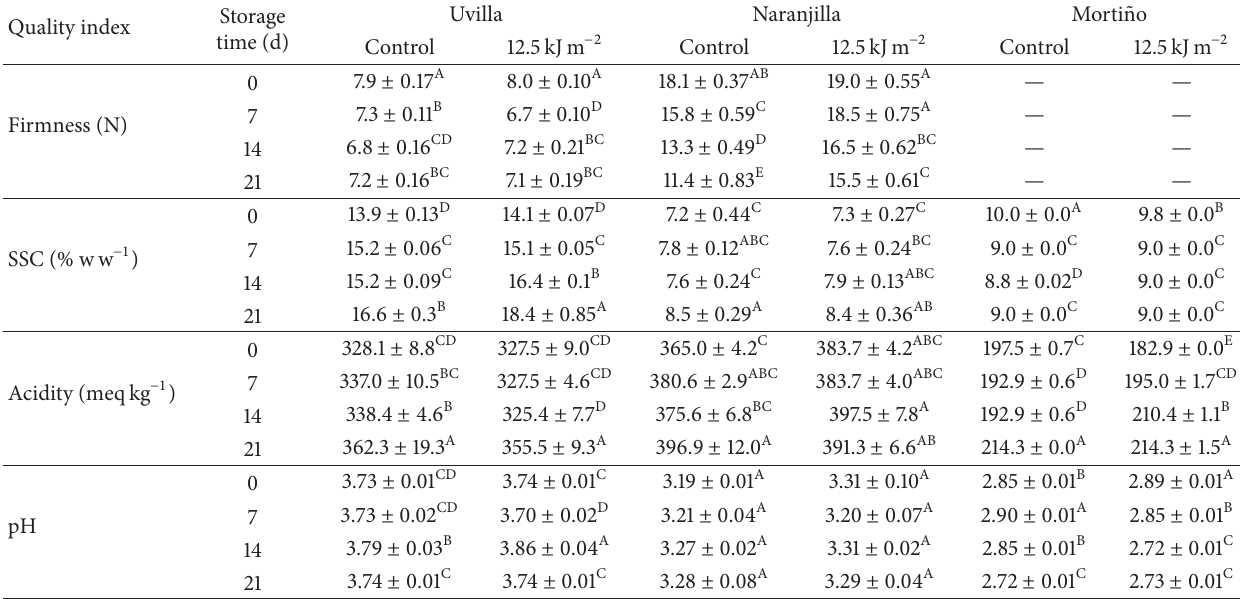
Table 1: Firmness, soluble solids content (SSC), titratable acidity, and pH in control and UV-C treated (12.5 kJm −2 ) uvilla, naranjilla, and morti˜no during storage at 6 ∘ C for 0, 7, 14, or 21d. For each fruit, different letters between treatments show differences according to a Fisher test ( 𝑃 < 0.05 ). The mean ± standard error is